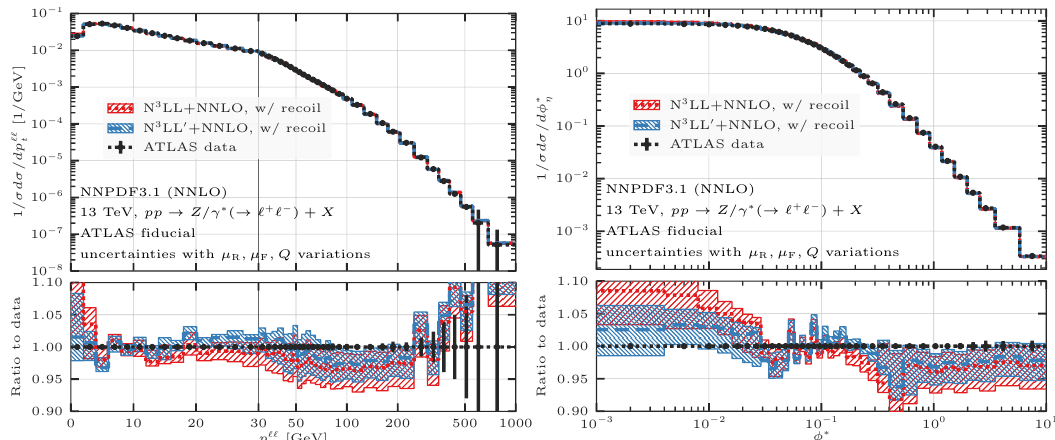
Figure 5 . Comparison of matched predictions at N 3 LL +NNLO (red) and N 3 LL 0 +NNLO (blue) with ATLAS data [97] for p ‘‘ (left panel) and φ ∗ (right panel). The fixed-order component is turned t η off below φ ∗ = 3 . 4 · 10 − 2 in the right panel, see main text for details. In the left plot, the x axis is η linear up to 30 GeV and logarithmic